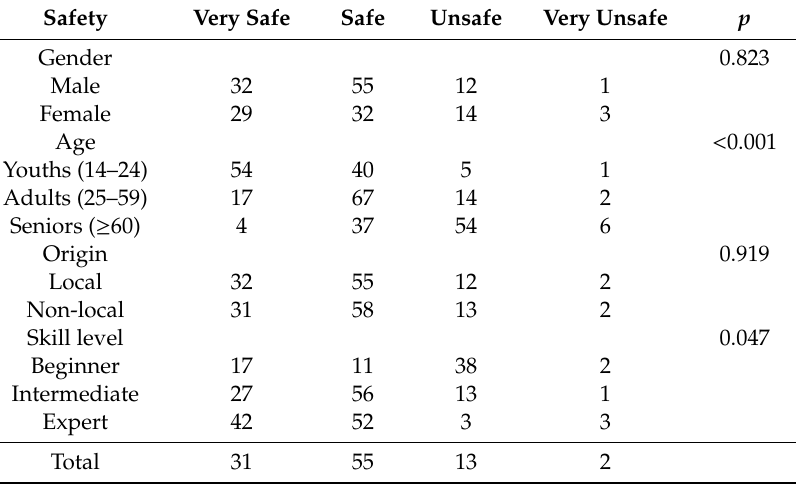
Table 3. Perception of safety on the slopes.